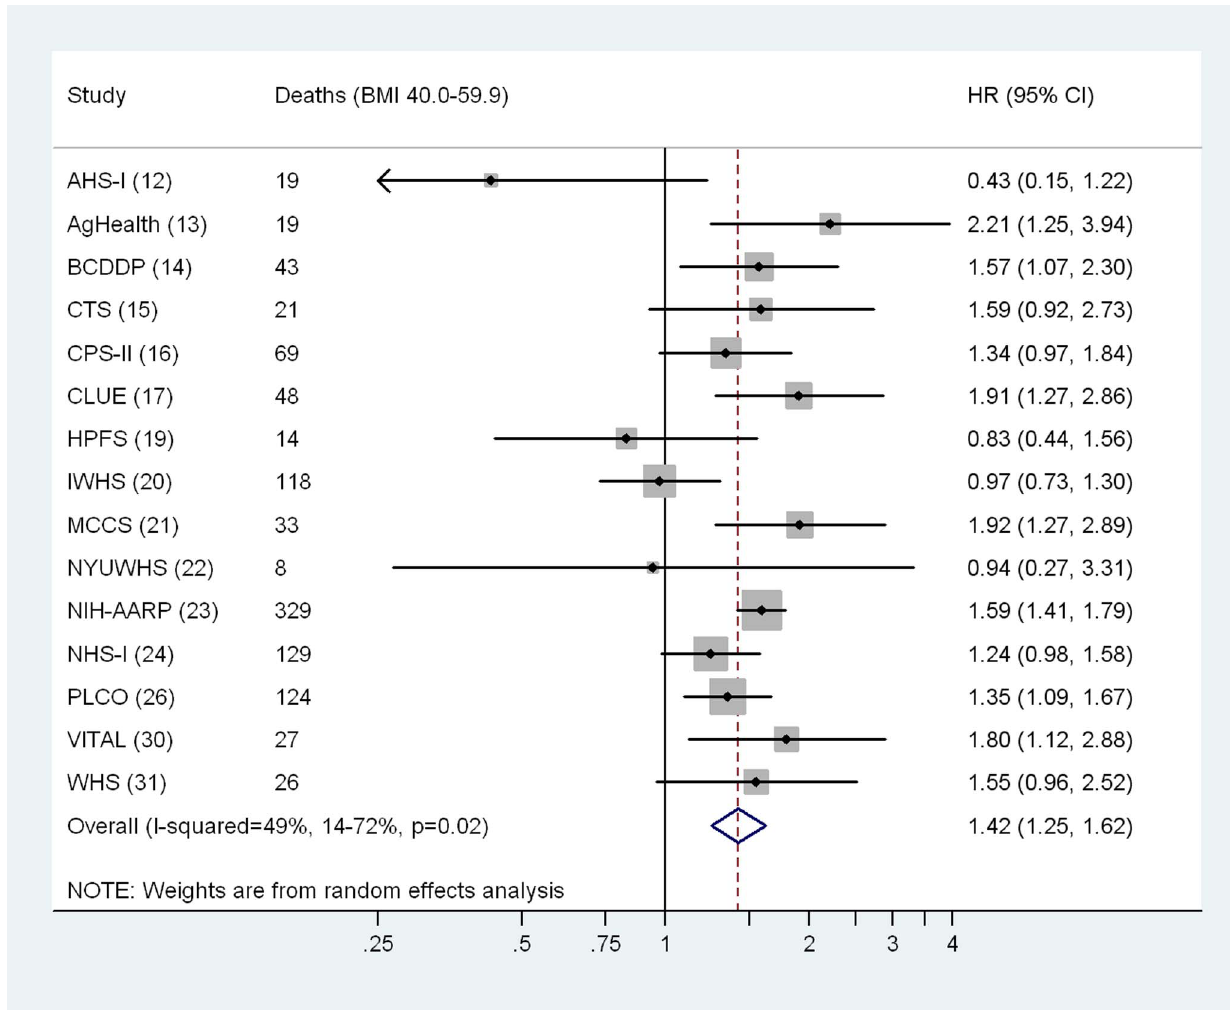
Figure 2. Cohort-specific and overall hazard ratios and 95% confidence intervals for continuous BMI (per 5 kg/m 2 ). Analyses were restricted to participants with BMI 40.0–59.9 kg/m 2 . Results for cohorts with fewer than five deaths in the BMI 40.0–59.9 kg/m 2 group are not shown. Cohort-specific models use attained age as the underlying time metric, and are adjusted for sex, race/ethnicity (white [all participants in the Swedish and Australian cohorts were coded as white], black, Asian/Pacific Islander, Hispanic, other/unknown), education (high school or less, post–high school, college, unknown), alcohol intake (grams of ethanol per day: 0, . 0 to , 10, $ 10, unknown), and physical activity level (cohort-specific tertiles corresponding to low, medium, and high). Random effects models were used to calculate overall (pooled) HRs and 95% CIs. The cohort acronyms are identified in Table 1, and references are given in parentheses.